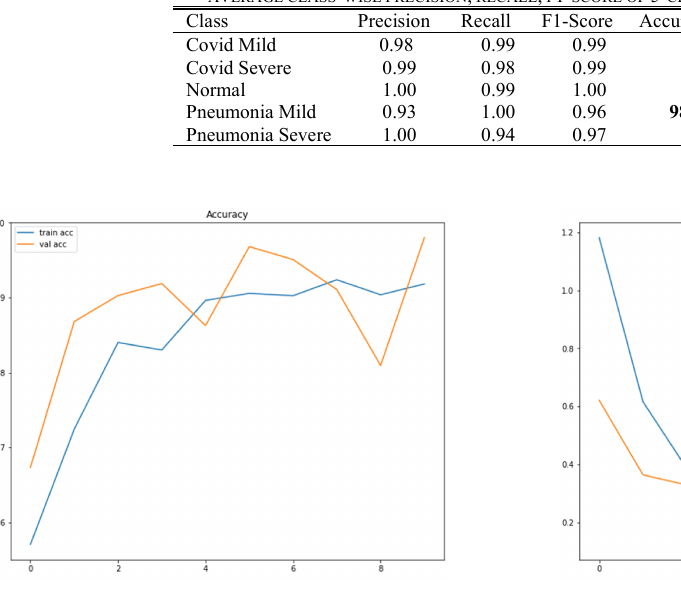
Fig. 7 Validation five class accuracy Fig. 8 Validation five class loss